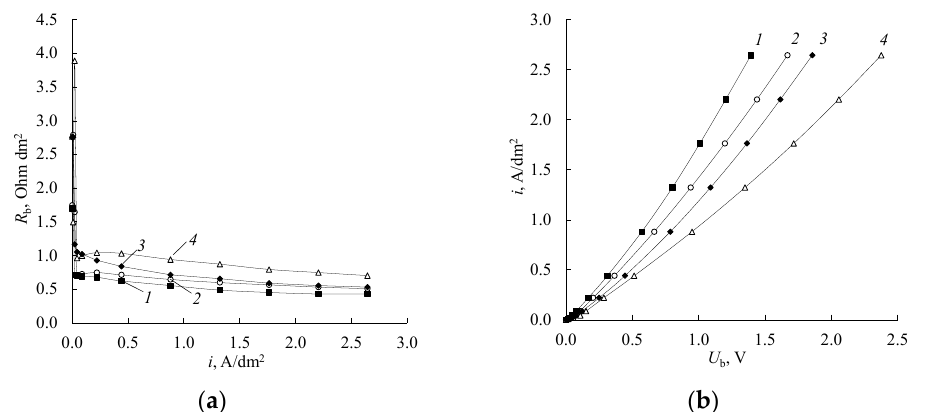
Figure 8. The dependence of the resistance of the bipolar region of the membrane on the current density ( a ) and the partial overvoltage current-voltage characteristics of the bipolar region ( b ) in systems «0.5 mol-eq/L H 2 SO 4 —0.25 mol-eq/L amine, 0.25 mol-eq/L amine sulfate». 1 —DMA, (DMA) 2 H 2 SO 4 , 2 —DEA, (DEA) 2 H 2 SO 4 , 3 —EDA, EDAH 2 SO 4 , 4 —MA, (MA) 2 H 2 SO 4 .